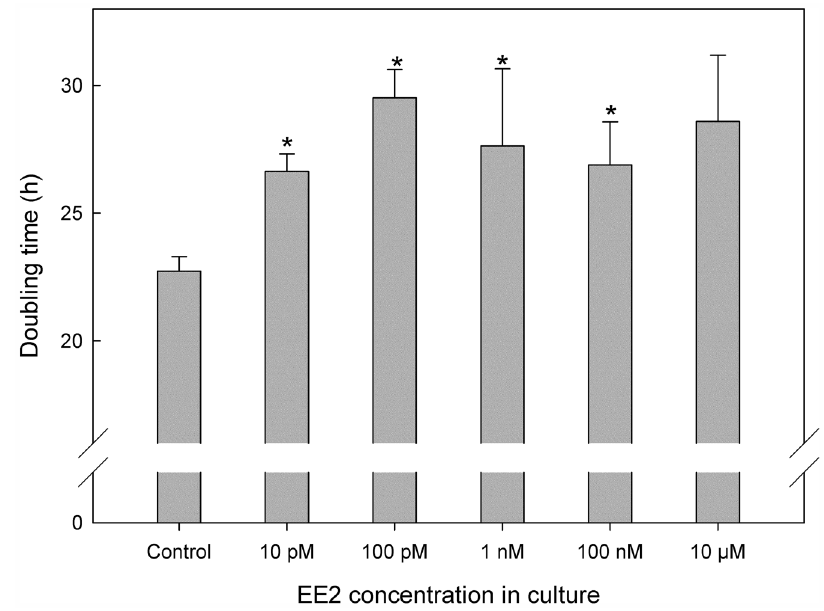
Figure 1. Growth doubling times for batch-grown cultures of C.reinhardtii grown in the presence of EE2 at concentrations ranging from 10 pM to 10 m M in the culture media. Control = no EE2 added. Growth was determined by daily measurements of A 750 , for a minimum of 10 days. Data represent means 6 SE, n=3. * above a bar indicates a significant change as compared to the control using a student’s t-test and p , 0.05.